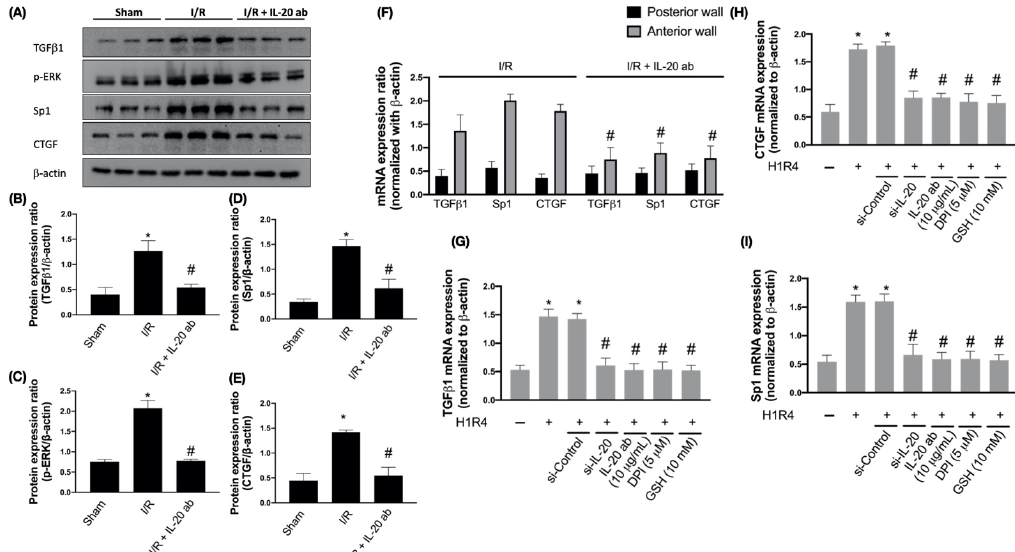
Figure 4. The effect of interleukin (IL)-20 antibody on ischemia/reperfusion (I/R)-induced upregulation of fibrosis factors. Sprague Dawley rats receiving sham operation or I/R treatment were studied. In the IL-20 antibody treatment group, animals were injected with 5 mg/kg IL-20 antibody at the phase of reperfusion. The left ventricular tissues were collected for Western blotting assay. Representatives of Western blot ( A ), and the densitometric analysis of transforming growth factor beta 1 (TGF β 1) ( B ), p-extracellular regulated protein kinases (ERK) ( C ), transcription factor specificity protein 1 (Sp1) ( D ), and connective tissue growth factor (CTGF) ( E ) were shown. ( F ) The mRNA levels of fibrosis factors in ischemic area (anterior ventricular wall) and nonischemic area (posterior ventricular wall) were investigated by quantitative real-time polymerase chain reaction assays. The data were presented as the mean ± standard deviation (SD) of six animals in each group. ( G – I ) The mRNA expression of fibrosis factors in H9C2 cells after hypoxia/reoxygenation (H/R) was examined. H9C2 cells that had been first exposed to hypoxia chamber with oxygen-glucose deprivation (OGD) for 1 h were moved into the normoxia chamber with high glucose medium for further 4 h, a condition abbreviated as H1R4. In some cases, cells were transfected with si-Control or si-IL-20 for 48 h before OGD. In the IL-20 antibody treatment group, 10 μ g/mL IL-20 antibody was added to medium during H/R. Glutathione (GSH), an antioxidant, was used for mitigating oxidative stress. Diphenyleneiodonium chloride (DPI), a nicotinamide adenine dinucleotide phosphate (NADPH) oxidase inhibitor, was used to inhibit H/R-induced NADPH oxidase activation. Data were presented as the mean ± SD of three different experiments. (* indicating p < 0.05 compared to the sham group or normoxia control cells; # indicating p < 0.05 compared to the I/R group or H/R cells). Sham: thoracotomy without ischemia/reperfusion; I/R: thoracotomy with ischemia/reperfusion; I/R + IL-20 ab: thoracotomy with ischemia/reperfusion plus IL-20 antibody injection. “ – “ indicated cells were exposed to normoxia chamber; “ + “ indicated cells were exposed to hypoxia chamber for 1 h followed by 4 h reoxygenation.